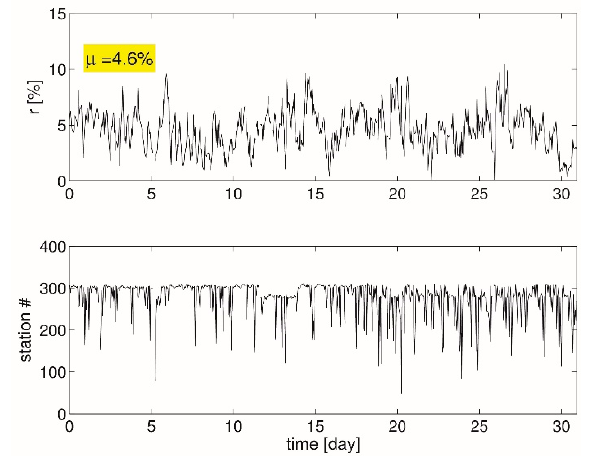
Figure 9. Upper panel: the reduction in the standard deviation in percentage, as a function of time, when GNSS ZWD estimates are corrected a posterior for the month of May in 2021. The number with the yellow background corresponds to the average reduction in the standard deviation. Lower panel: the number of samples (corresponding to the number of stations that provide ZTDs), as a function of the time.